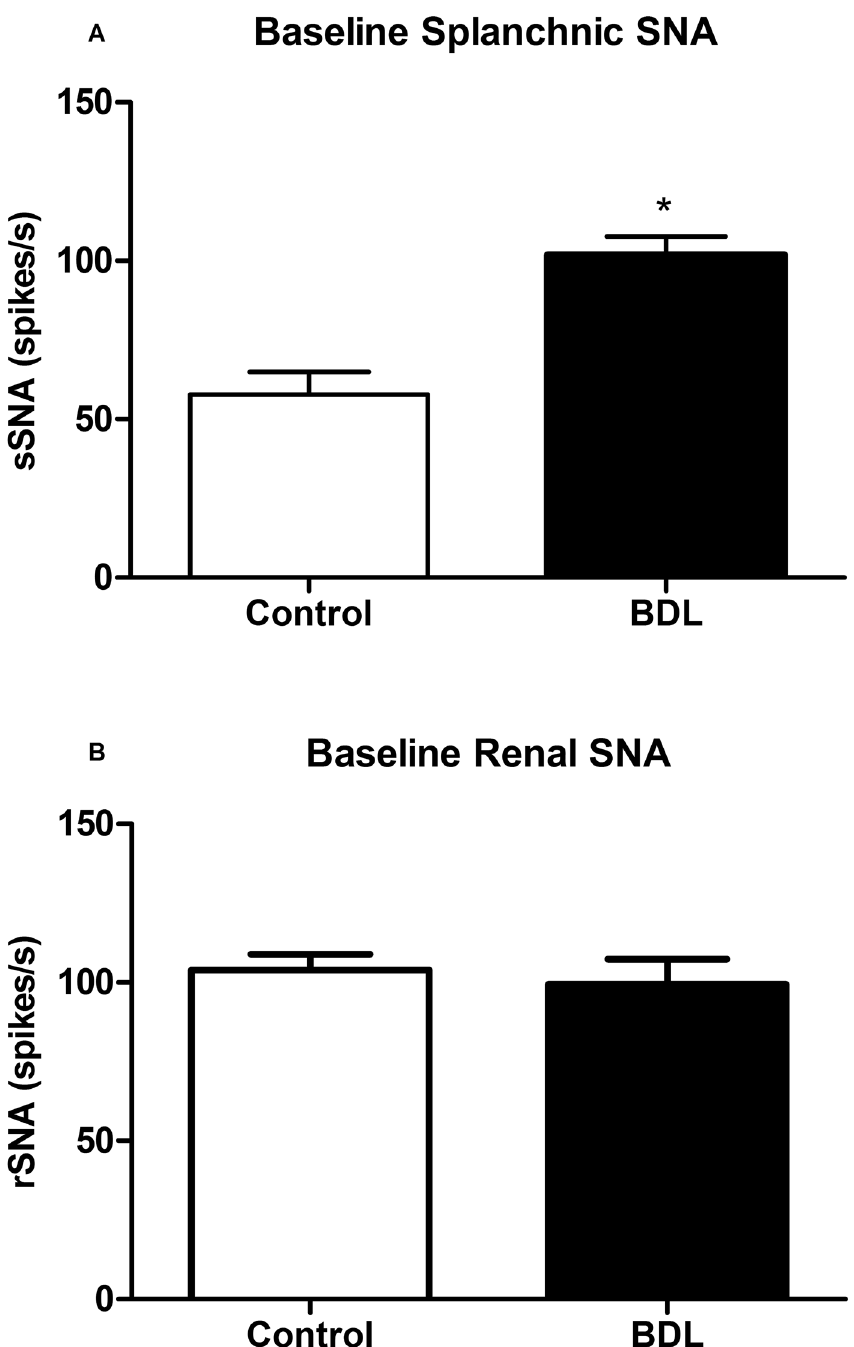
Fig 2. Baseline sympathetic nerve activity. ( A ) Splanchnic sympathetic nerve activity (sSNA, n = 9) and ( B ) renal sympathetic nerve activity (rSNA, n = 9) at baseline level in the different groups. BDL, bile duct ligation. Error bars indicate SEM. * p < 0.05 compared to control group (Student ’ s t test).